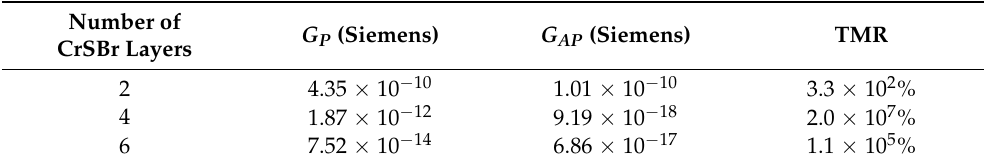
Table 1. The values of (cid:1833) (cid:3017) (the 2nd column), (cid:1833) (cid:3002)(cid:3017) (the 3rd column) and TMR (the 4th column) of MTJs with different numbers of CrSBr layers through calculations.